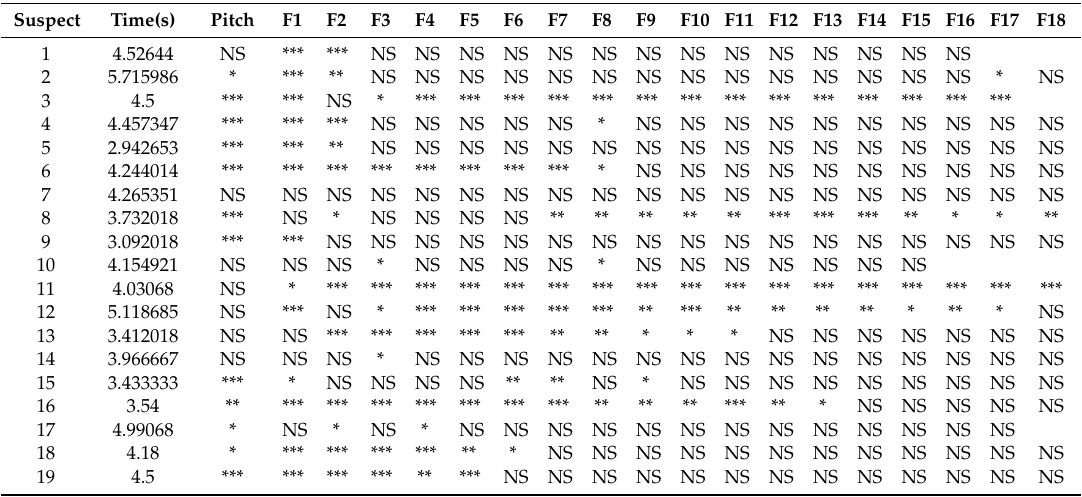
Table 3. The results of the comparison between the suspects (Sentence #3) and reference (Sentence #2). Suspect Time(s)